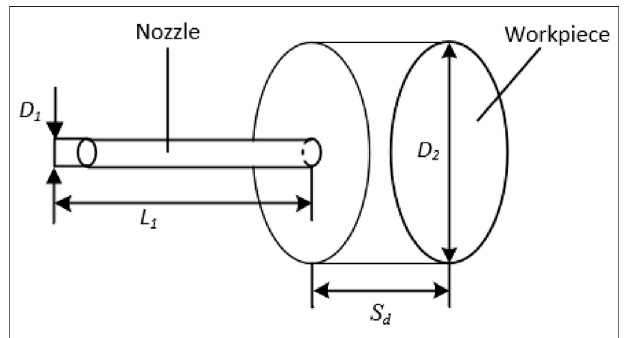
FIGURE 1 | Geometry model of the fl ow fi eld.